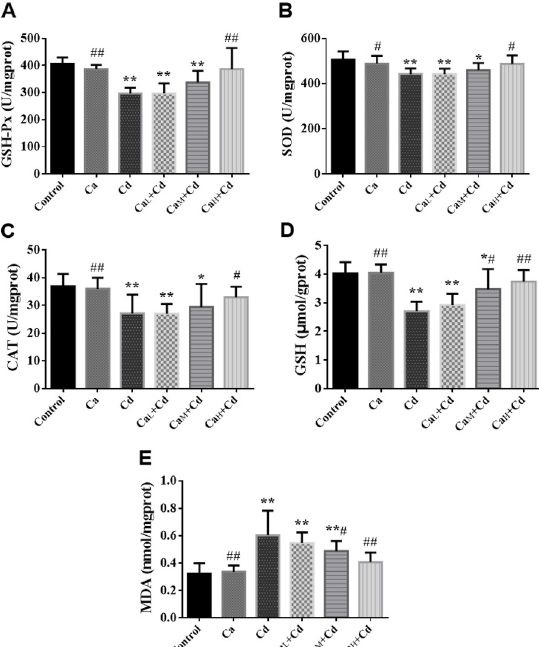
Fig 3. The activity of GSH-Px (A), SOD (B) and CAT (C) and the content of GSH (D) and MDA (E) of liver in different groups. The data are shown as mean ± SD. � P < 0.05, compared with control-group. �� P < 0.01, compared with control-group. # P < 0.05, compared with Cd-group. ## P < 0.01, compared with Cd-group.